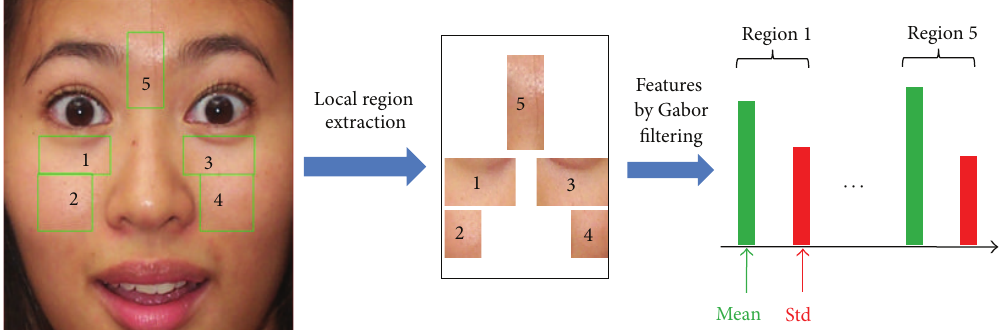
Figure 10: The 5 selected areas for extracting wrinkle